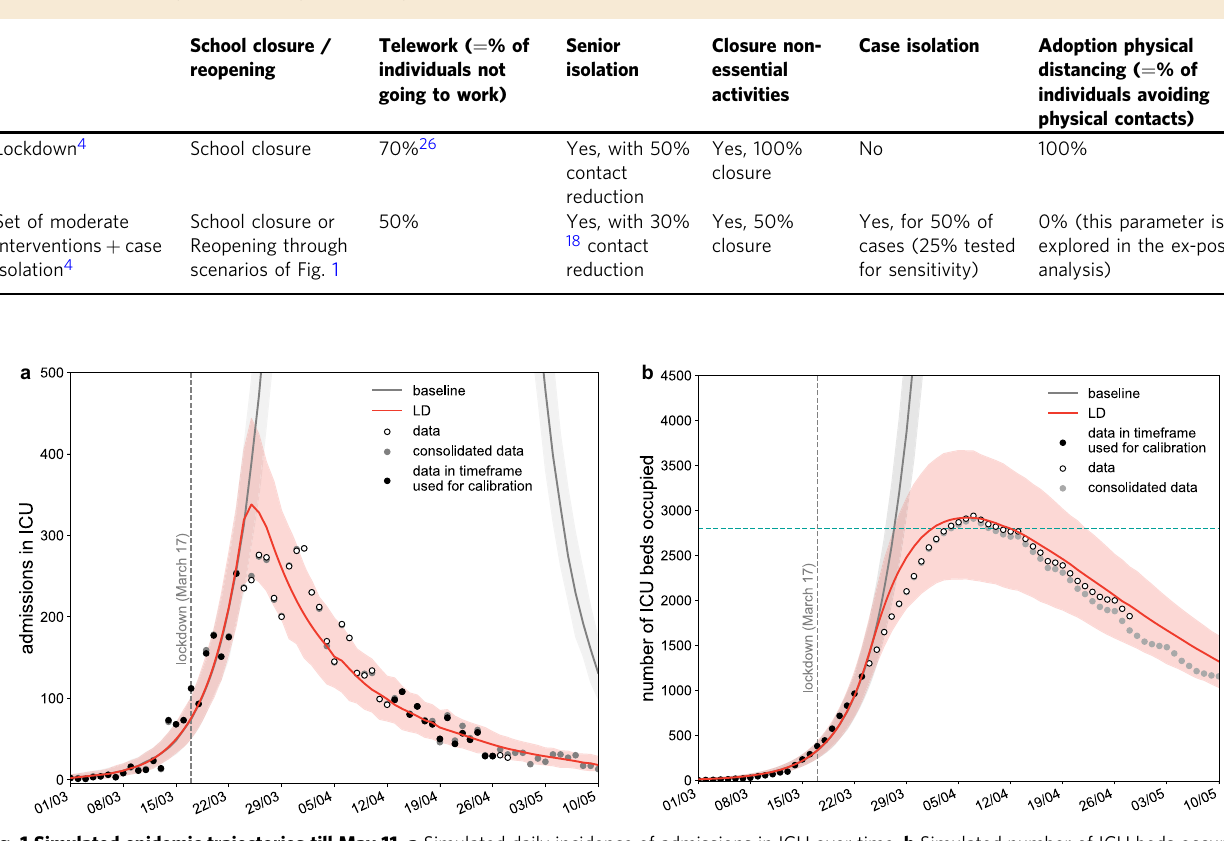
Fig. 1 Simulated epidemic trajectories till May 11. a Simulated daily incidence of admissions in ICU over time. b Simulated number of ICU beds occupied over time. The fi tted curve slightly overestimates the data, likely because it does not account for the transfer of patients in intensive care to less affected regions. Vertical dashed line refers to the start of the lockdown; curves and shaded areas correspond to median and 95% probability ranges, obtained from n = 500 independent stochastic runs; horizontal line refers to strengthened ICU capacity in the region to face the fi rst COVID-19 wave; LD stands for lockdown. Black dots indicate data used for the calibration; gray dots indicate data that became available after the initial submission of this